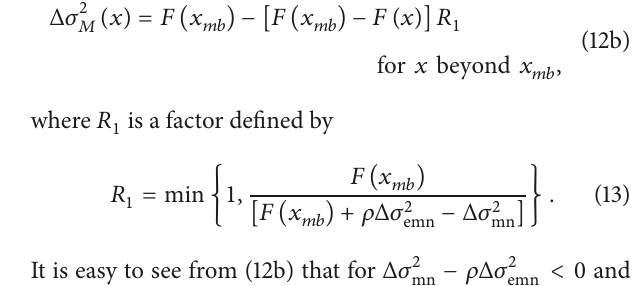
Figure 6: As in Figure 3 but for the case in Figure